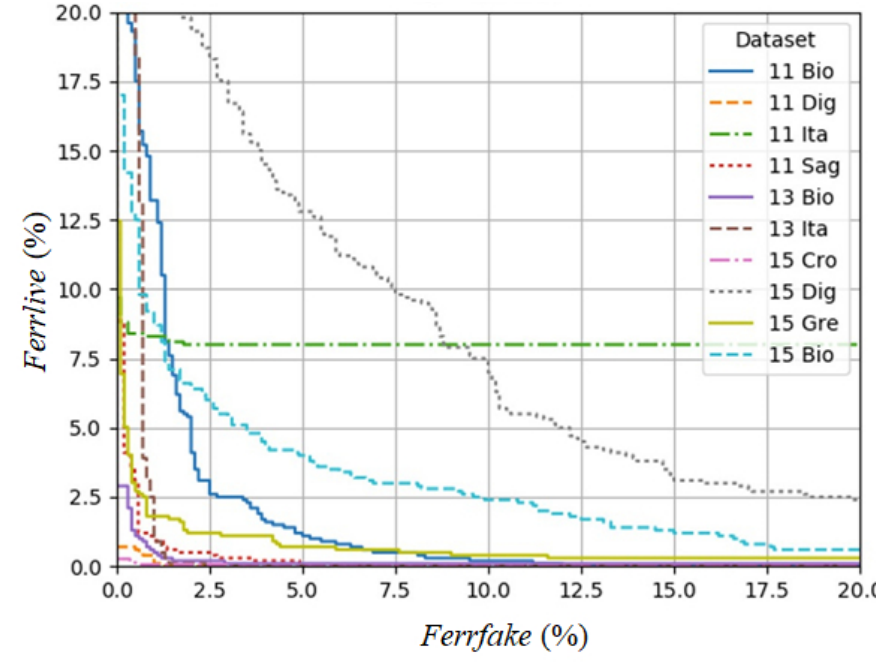
Figure 10. Magnification of DET graph in Figure 9 (focusing on the area of a zero to 20% error